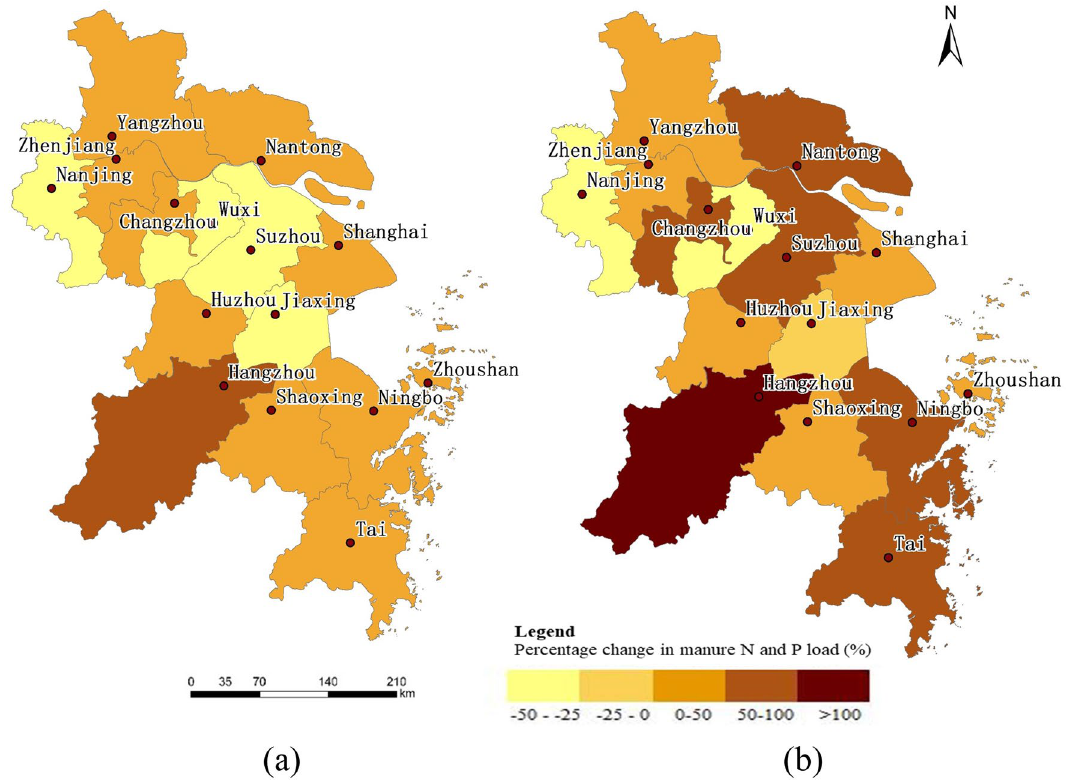
Figure 6. ( a ) Percentage change of manure N loads from 1980 to 2018; ( b ) Percentage change of manure P loads from 1980 to